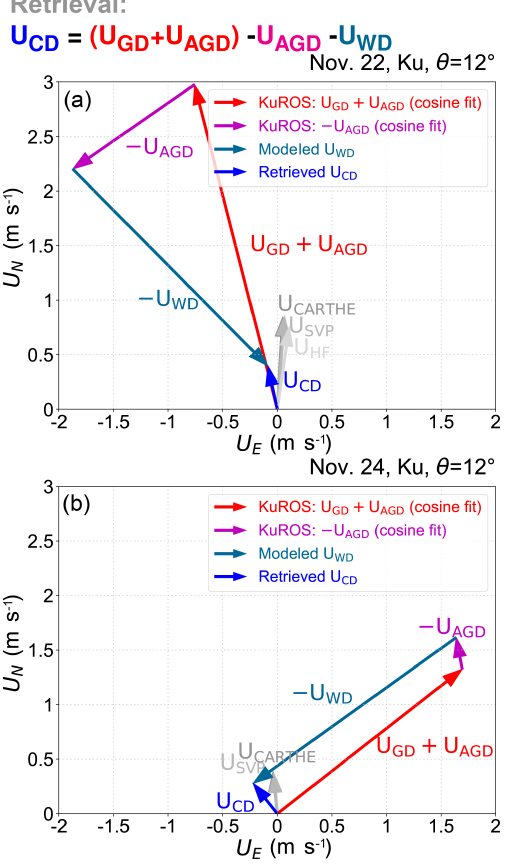
Figure 16. Comparison of KuROS-derived Doppler velocity, cor- rected for the U AGD and U WD wave contributions, with in situ (CARTHE, SVP drifters and HF radar) current measurements on (a) 22 and (b) 24